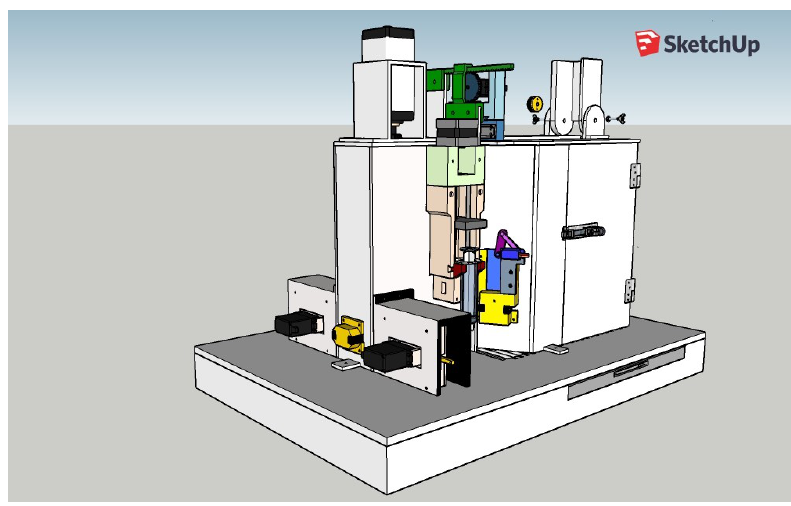
Figure 10. Sketch (project) of the complete automated behavior box.